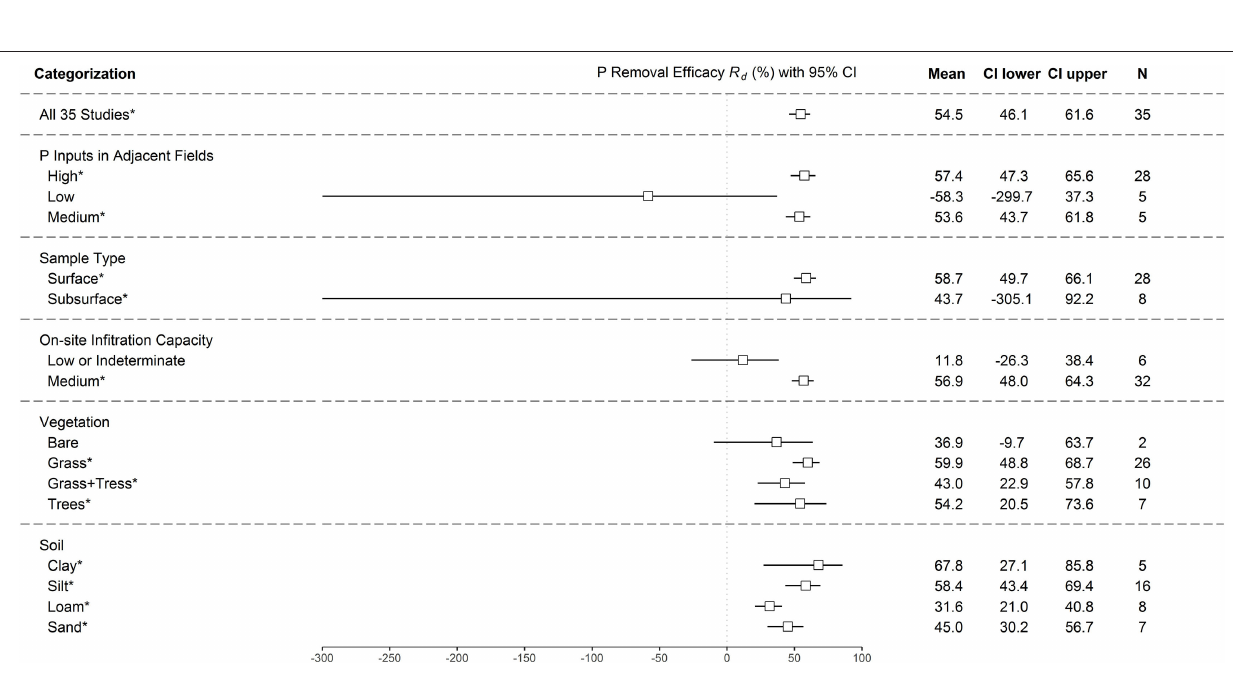
Frontiers in Water |